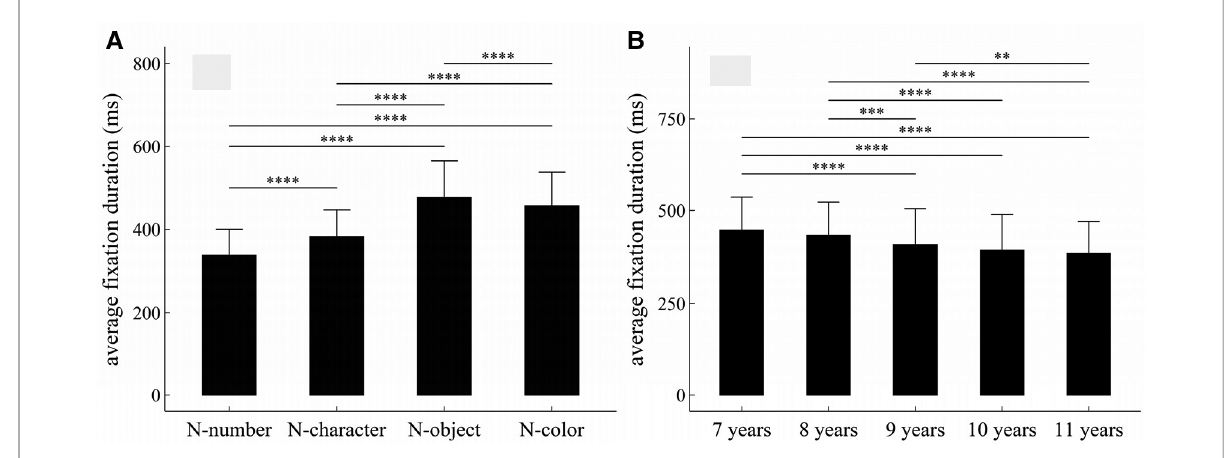
FIGURE 4 In fl uence of task-type, gender and age on average fi xation duration: ( A ) in fl uence of task-type; ( B ) in fl uence of age. * p <0.05; ** p <0.01; *** p < 0.001; **** p <1×10 − 4